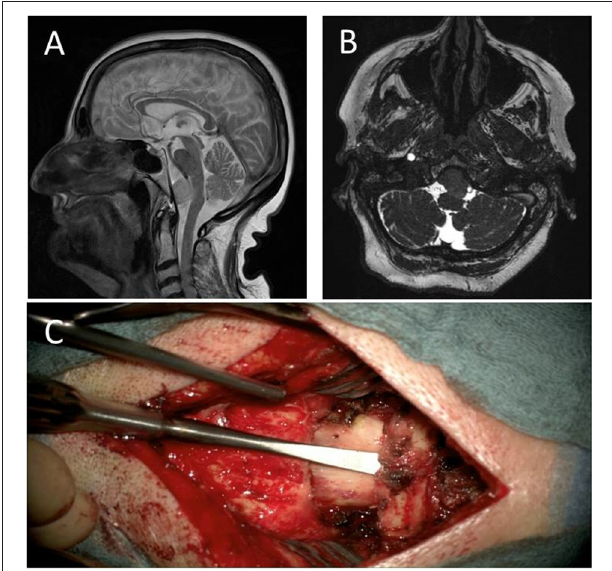
FIGURE 4 | Preoperative sagittal T2-weighted (A) MRI of case 3 depicting a foramen magnum and lower clivus meningioma with a cranial extension up to the vertebral junction. Axial 3D-CISS images (B) show a sufficiently wide craniocervical cerebrospinal fluid (CSF) space and a bilaterally well distinguishable vertebral artery. After preparation of the paravertebral muscles, an Adson retractor was placed exposing all boney structures from occiput down to C2 (C) showing a wide enough space for tumor resection.